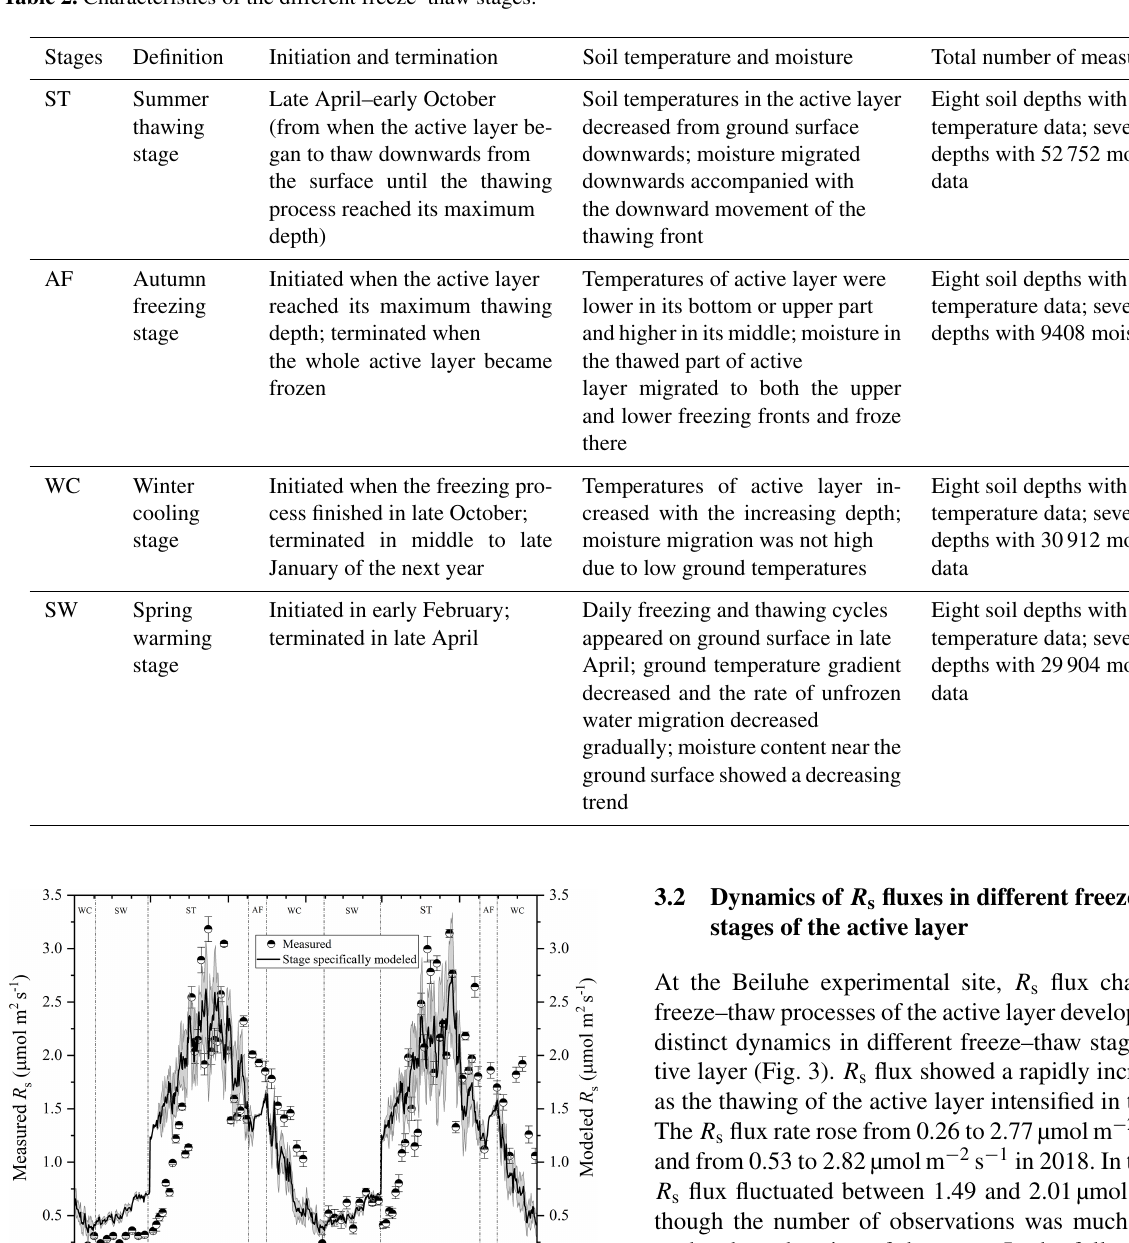
Table 2. Characteristics of the different freeze–thaw stages.